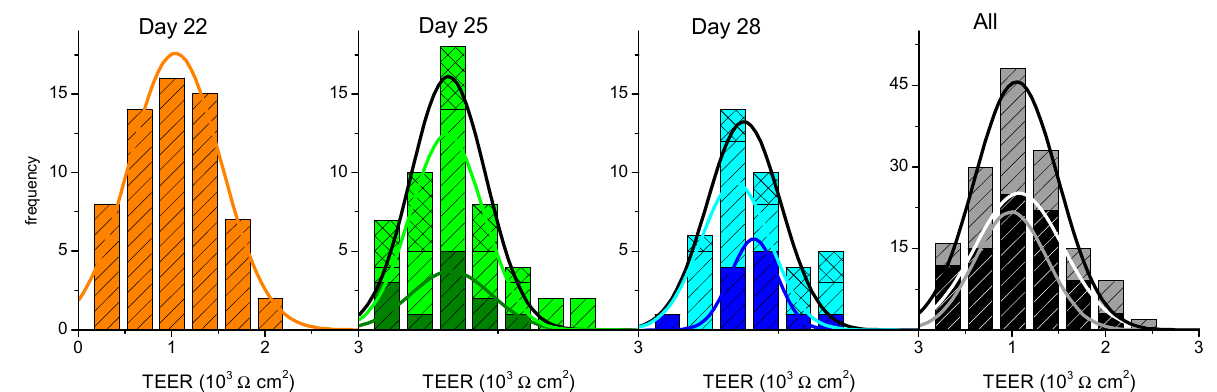
Figure 2. Evaluation of the re-establishment of Caco-2 monolayer integrity when incubated in cul- ture media for two full days after being used for a permeability assay. The TEER values for cell monolayers not used on permeability assays are shown in dark colors ( , , ), and those previ- ously used are shown in light colors ( and , TEER on day 25 previously used on day 22; and , TEER on day 28 previously used on days 22 and 25, on single or multi-time sam- pling). The lines are the best fit of a Normal distribution to the results obtained on single use or re- used cell monolayers (colored lines) or cumulatively for each day (black line), with the parameters given in the supplementary material—Table S2.1. The cumulative results at all days are shown on the right plot ( , TEER before assay on days 22, 25, or 28; , TEER before assay on days 25 or 28 after being used on day 22 or on days 22 and 25).